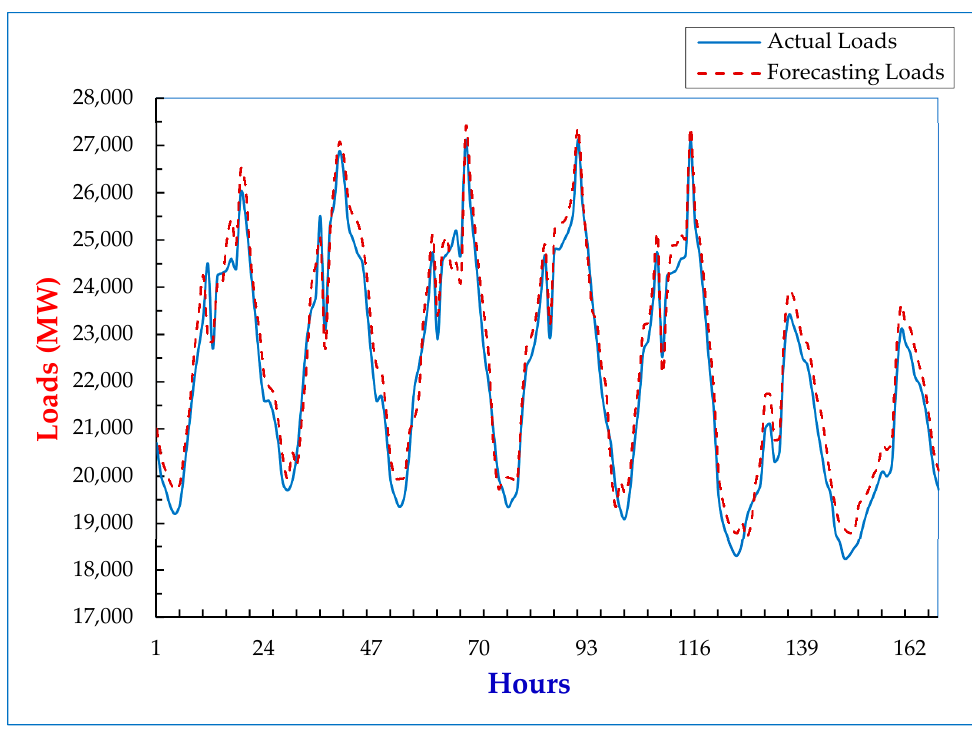
Figure 9. Load forecasting for the typical 2020 autumn week (Monday 21 September 2020 to Sunday 27 September 2020).